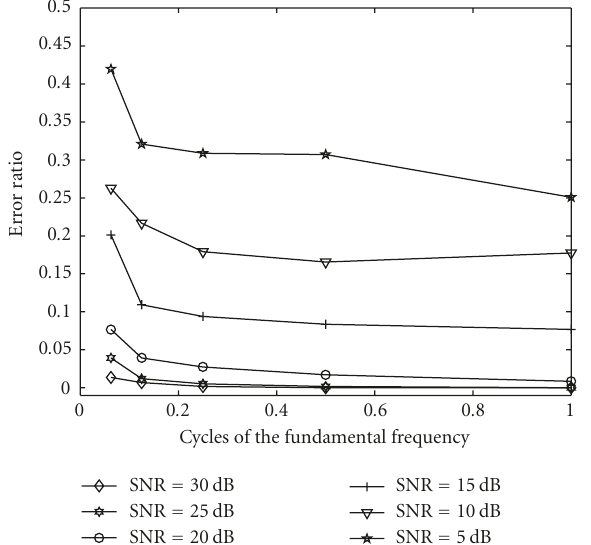
Figure 12: Error detection rate attained by HOS when the frame length is equal to 1/16, 1/8, 1/4, 1/2, and 1 cycles of the fundamental component and the SNR ranges from 5 up to 30dB.